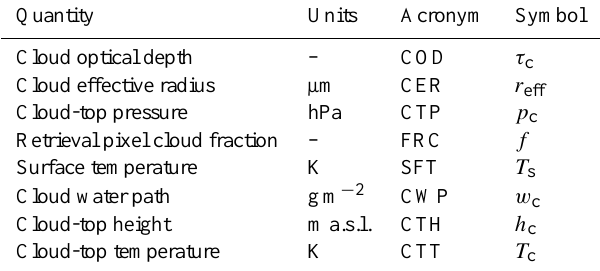
Table 1. Retrieved state vector (and derived) quantities, units, acronyms and symbols used in this work. The first five quantities are retrieved, along with the cloud phase (ice/water), and the final three derived. Note that the COD is retrieved in log 10